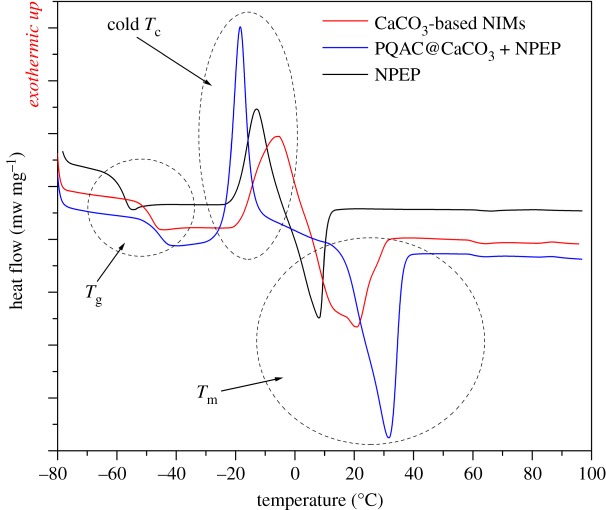
DSC thermograms of CaCO3-based NIMs, pristine NPEP and a mixture of PQAC-CaCO3 nanoparticles and pristine NPEP.